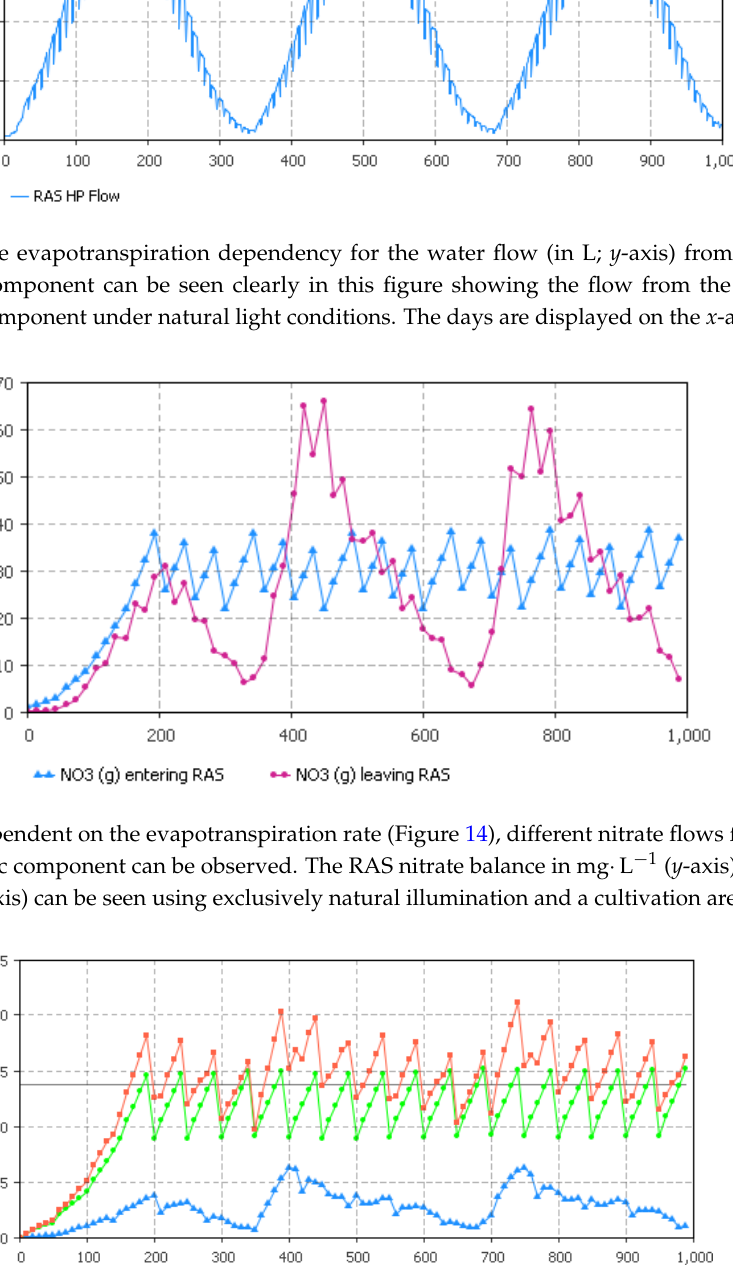
Figure 16. P dynamics in the hydroponic component with a cultivation area of 600 m 2 . The P lettuce consumption ( y ‐ axis) is assumed being constant, although this is not the case. However, this does not diminish the lettuces N total uptake. The days are displayed on the x ‐ axis.